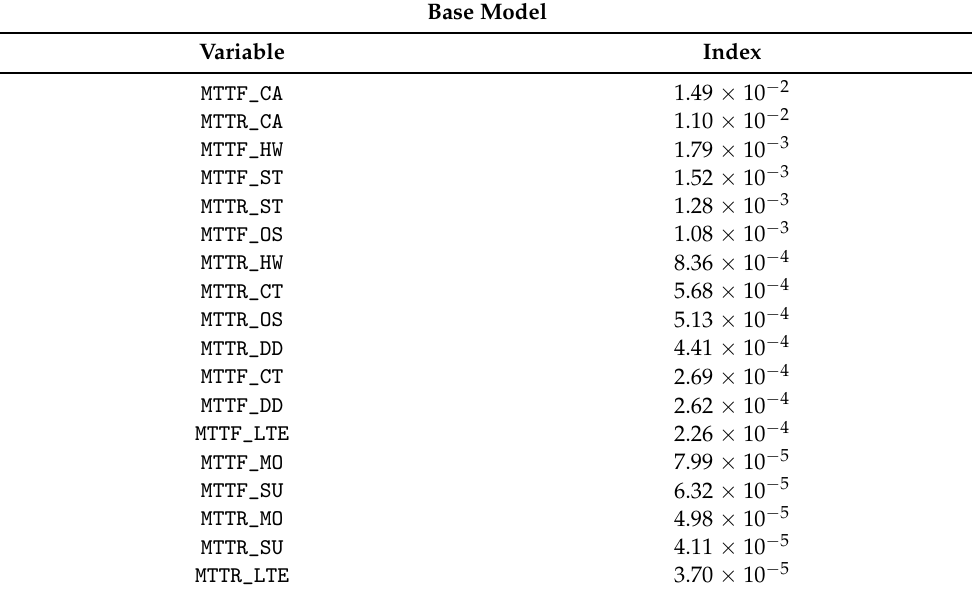
Table 4. Sensitivity indices.